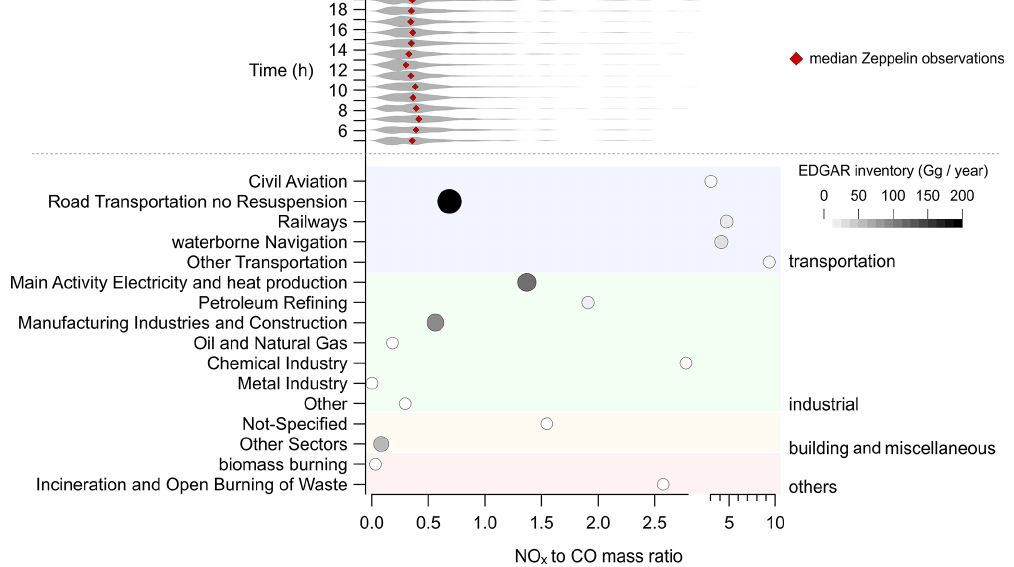
Figure 5. Distribution of the NO x to CO ratio (gg − 1 ) during the Zeppelin flights shown as a violin plot for measurements ranging from 250 to 450m in height. These ratios are compared to the ratios of different pollution sources following the EDGAR 2015 emission inventory. The size and color of the markers indicate the NO x emission strength for each EDGAR source.